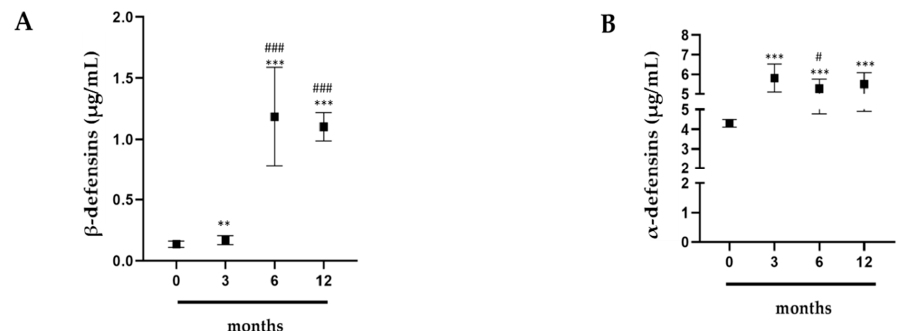
Figure 1. ELISA assay. ( A ) Beta-defensin and ( B ) alpha-defensin levels of 15 professional basketball athletes at 0, 3, 6, and 12 months since the start of a championship competition. The data are expressed